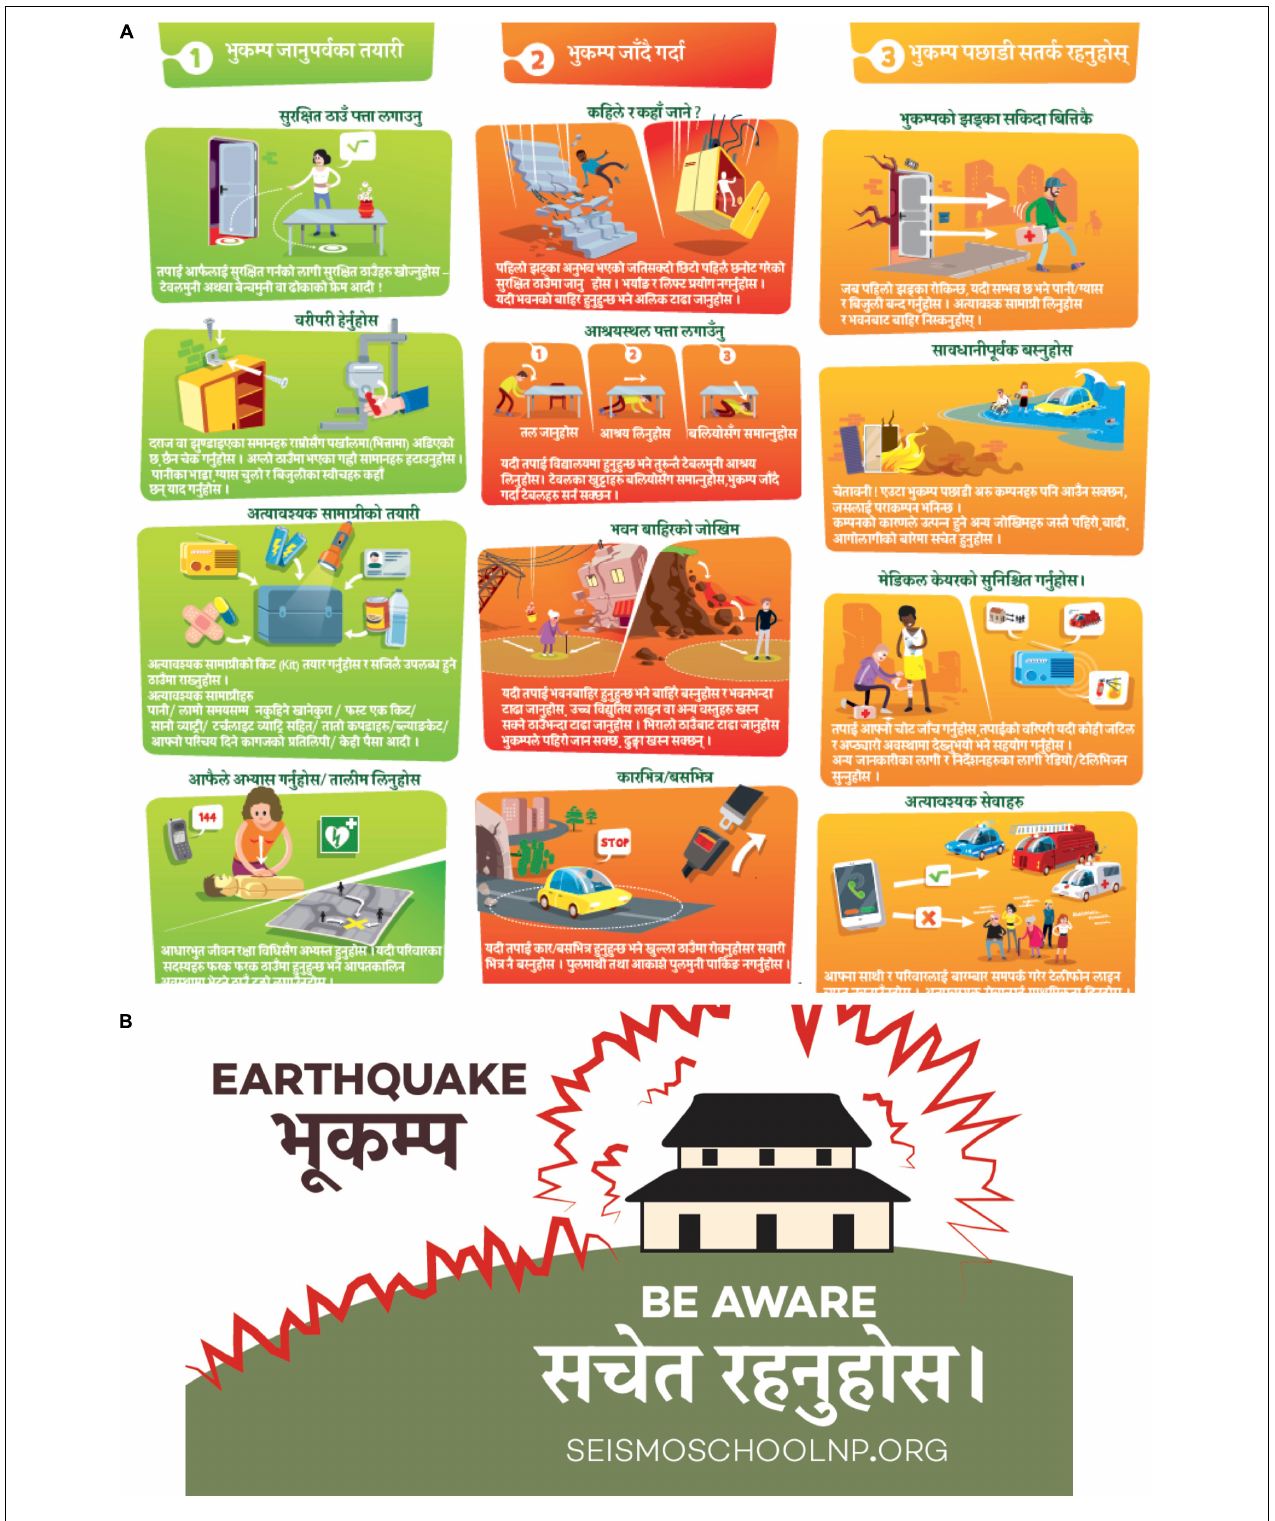
FIGURE 3 | (A) An important teaching material: a flyer prepared in Nepali language on what to do before, during and after an earthquake, illustrated in detail with pictures. The flyer is adopted from the English version which was initially prepared by and for the Earthquake Education Center, Switzerland (http://www.cpps-vs.ch). The full flyer is freely available from our website directly at: http://seismoschoolnp.org/wp-content/uploads/2019/11/Be-Prepared-Nepali.pdf. (B) Earthquake awareness sticker aimed as a reminder, in English and Nepalese language.